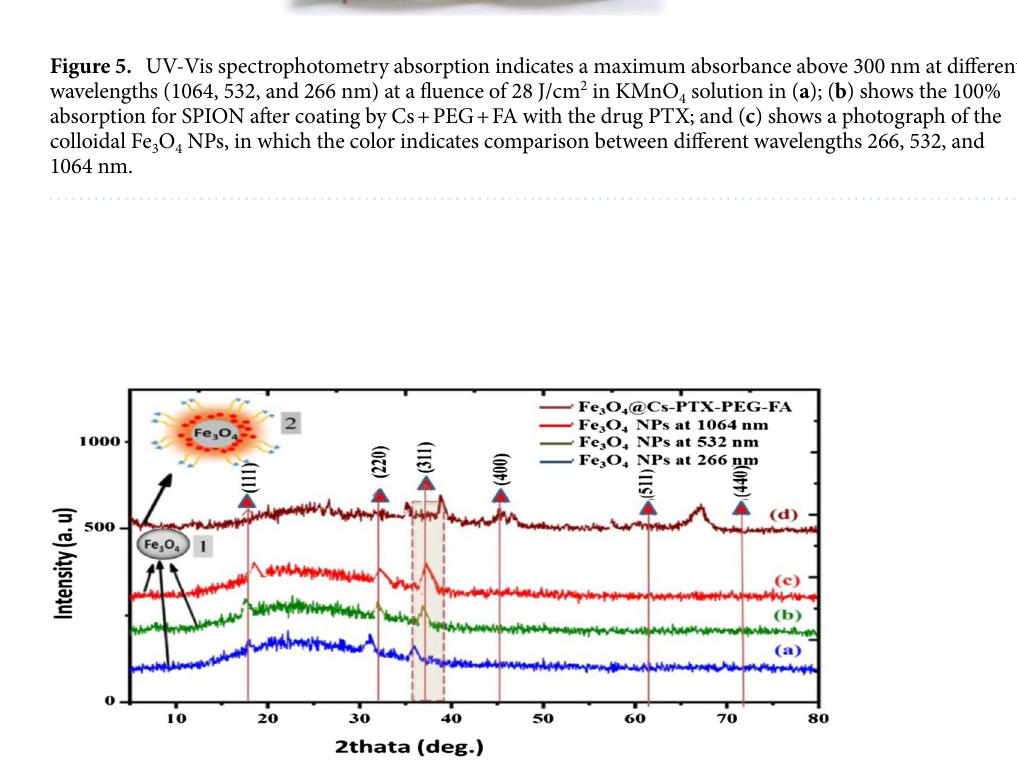
Figure 6. X-Ray diffraction patterns of Fe 3 O 4 NPs (1) prepared by different wavelengths (1a, λ = 1064 nm; 1b, λ = 532 nm; 1c, λ = 266 nm in KMnO 4 solution; and 2d, SPION@PTX-Cs-PEG-FA for λ = 266